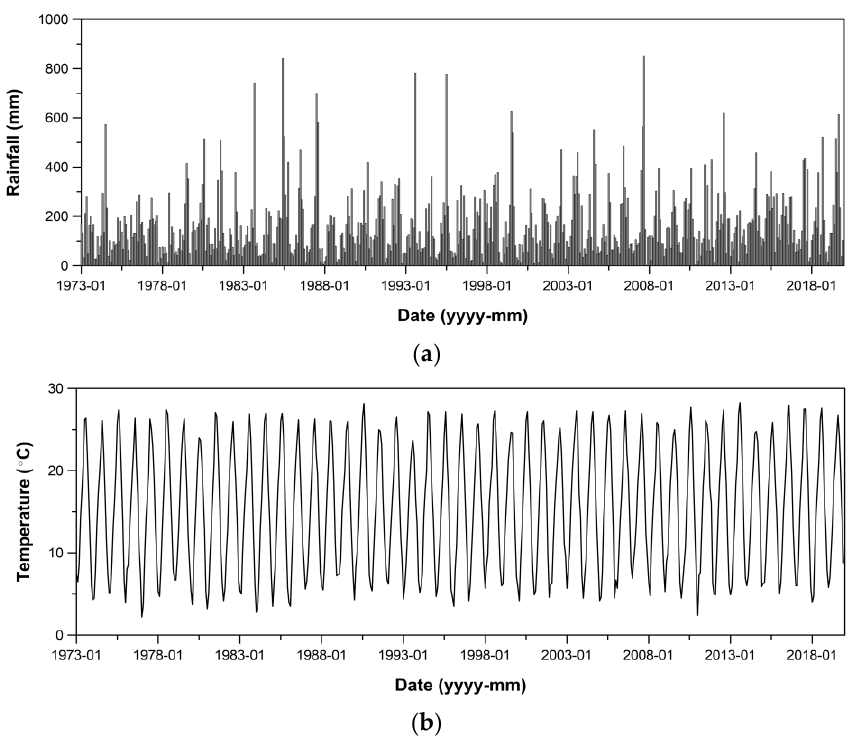
Figure 6. Monthly rainfall ( a ) and temperature ( b ) data collected at the Seongsan meteorological station (1973–2019). The pan evaporation data are also available at the Seongsan weather station, but only from 1977 to 1990. Measurement was discontinued from 1991. As it was not possible to